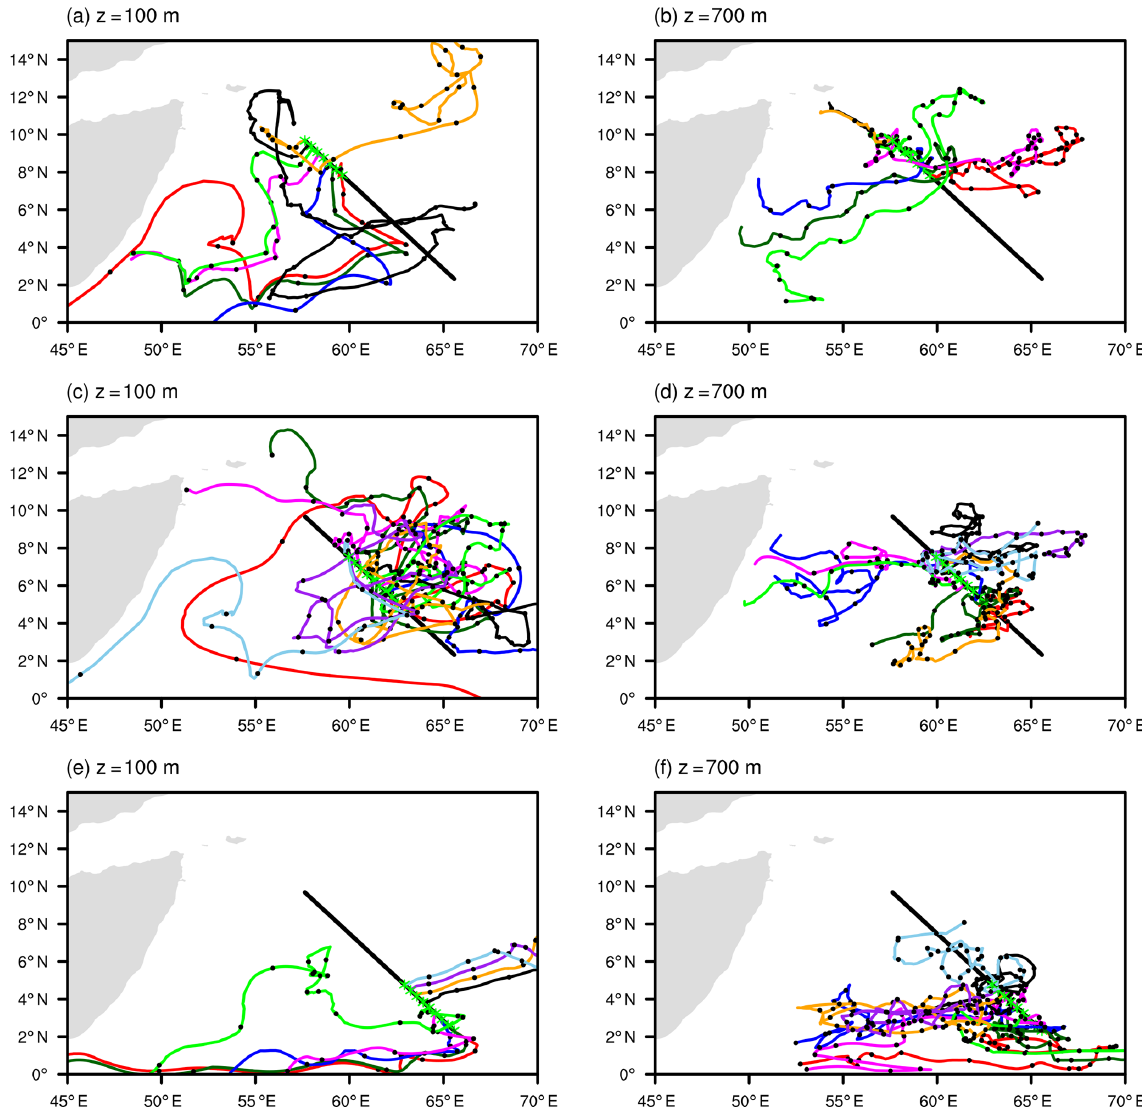
Figure 6. Passive tracers using SODA reanalysis. The Carlsberg Ridge is presented by black line. The tracers at 15 May 2012 are shown as green asterisks (ending points). The tracers are backtracked to 1 January 2010. The time interval is 1 month, as denoted by the black dots. (a, b) 8–9.8 ◦ N; (c, d) 5–8 ◦ N; (e, f) 2-5 ◦